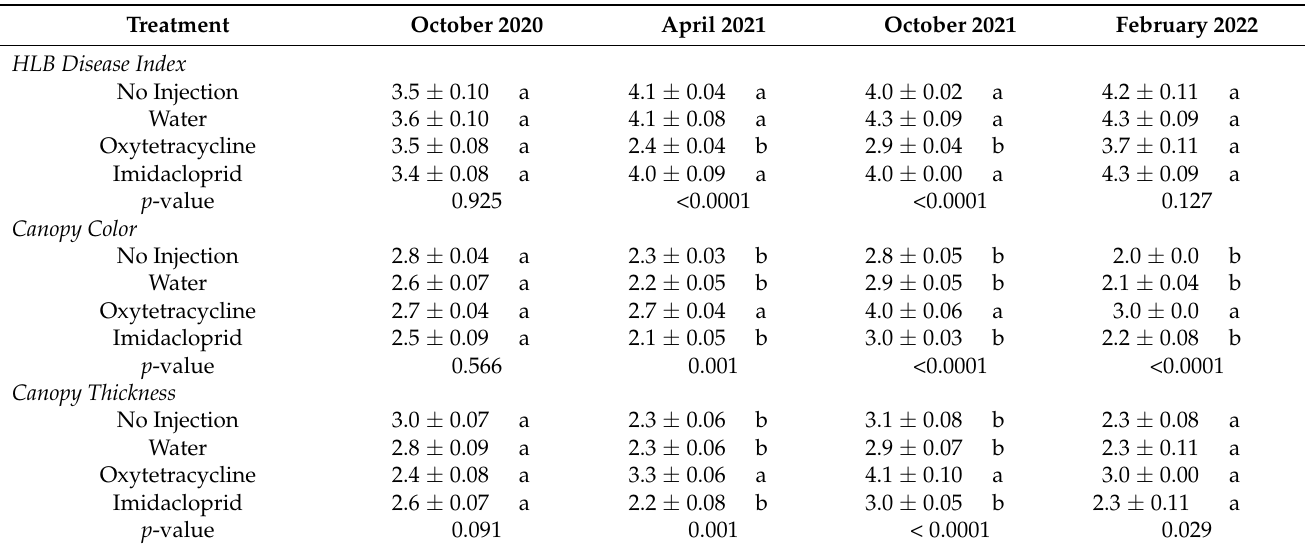
Table 2. Foliar Huanglongbing (HLB) disease index, canopy color, and canopy density of